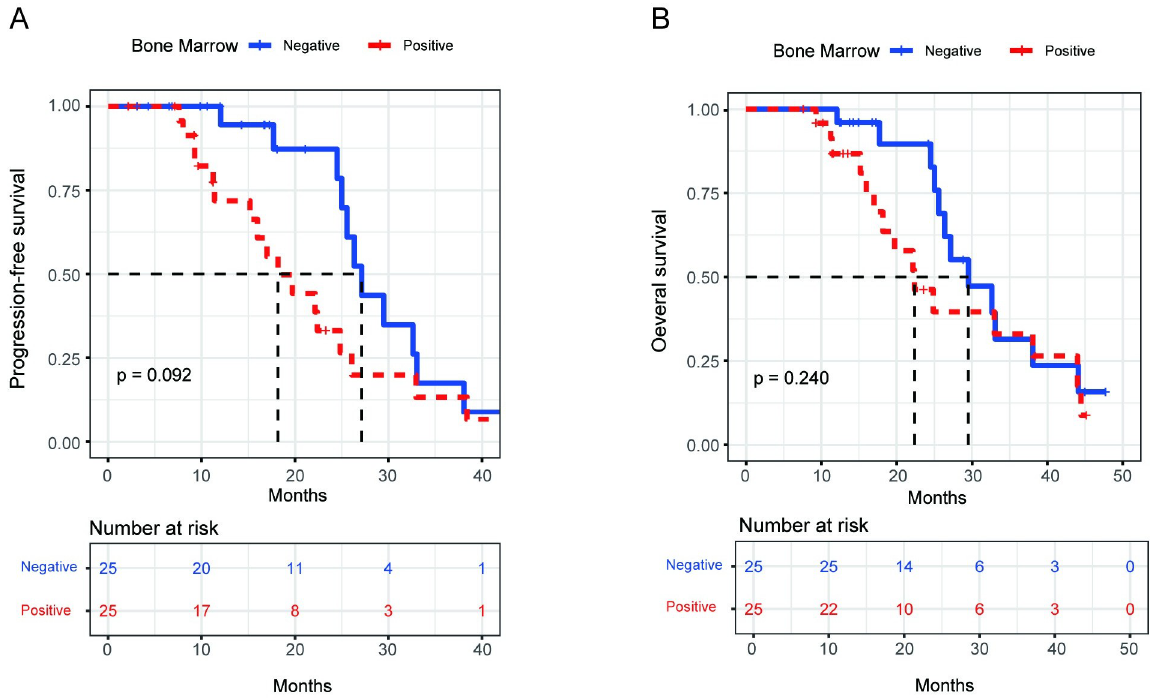
Fig 7. Survival curves of patients diagnosed using bone marrow biopsy/smear after propensity-score matching. (A): Progression-free survival curve. (B): Overall survival curve.